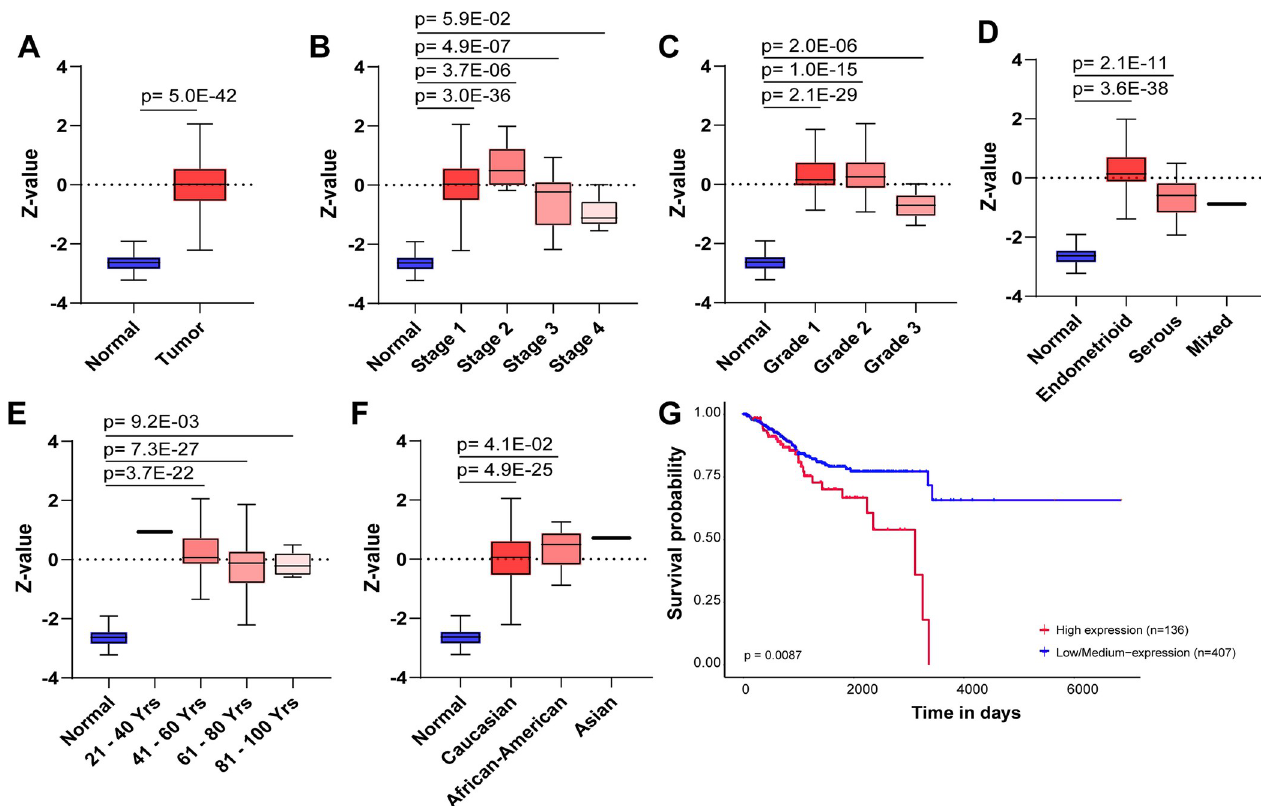
Fig 4. MYO5B protein levels are elevated in UCEC patients. Protein levels of MYO5B as determined by mass spectrometry-based proteomics (z-value) in normal and A. grouped UCEC tumor samples; B. stage 1, 2, 3 and 4 UCEC tumors; C. tumor grade; D. endometroid, serous, or mixed tumor types; E. patient age; F. menopause status, or G. patient